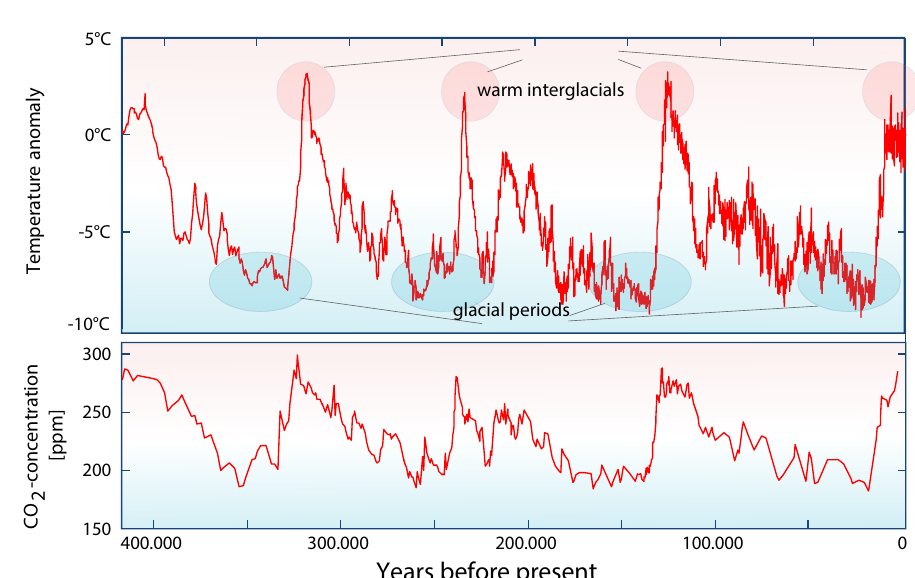
Fig. 2. – Fluctuations of Earth temperature and atmospheric CO 2 concentration over the past 400000 years, from the Vostock ice